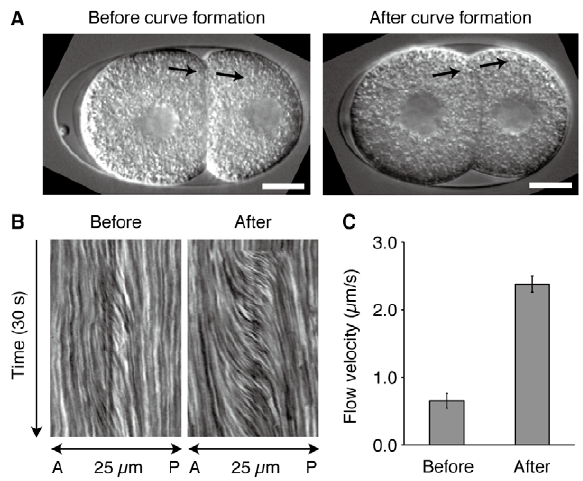
Figure 2. Laser-induced cell fusion is accompanied by cyto- plasmic flow. (A) AB and P 1 were laser fused either before (left) or after (right) their contact surfaces formed curves. Arrows indicate the location and direction of the observed flow of cytoplasmic granules. Scale bars, 10 m m. (B) Kymographs of cytoplasmic flow. A, anterior; P, posterior. (C) The velocity of cytoplasmic flow before and after curve formation (n=10 each). Error bars indicate s.e.m.